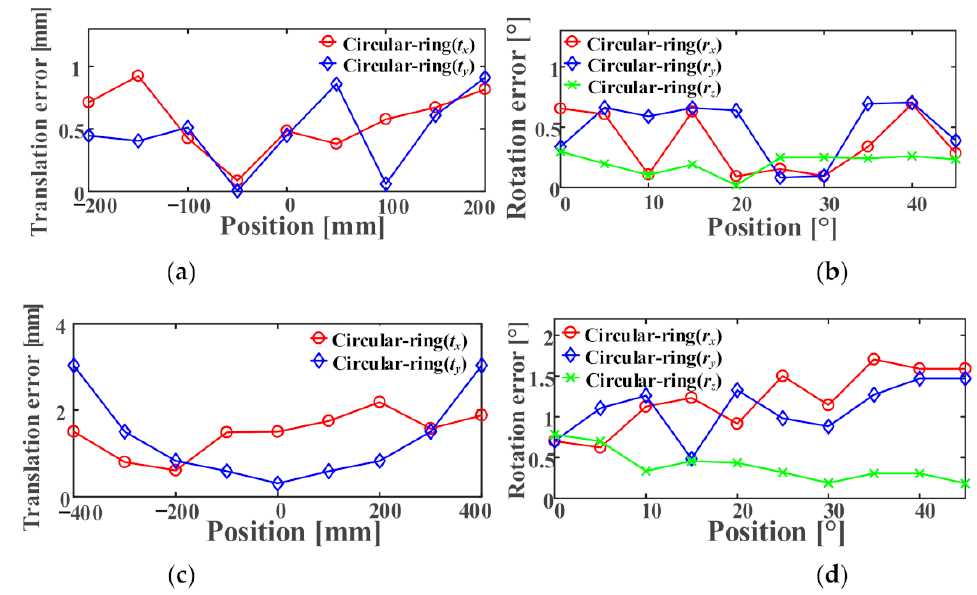
Figure 13. The translation and rotation accuracy of X and Y-axis at 2 m and 4 m: ( a ) Translation error along the X and Y-axis at 2 m; ( b ) Rotation error along the X and Y-axis at 2 m; ( c ) Translation error along the X and Y-axis at 4 m; ( d ) Rotation error along the X and Y-axis at 4 m.